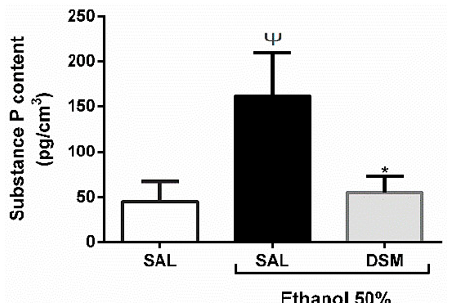
Figure 4. Effects of DSM supplementation on SP contents in gastric mucosa. The amount of SP in gastric mucosa was estimated by enzyme-linked immunosorbent assay (ELISA) and results were expressed as pg/cm 3 . Data shown are the mean ± SEM of at least 5 mice per group. The healthy group was treated with saline only. Ethanol administration significantly increased the gastric concentration of SP. This effect was reverted significantly when the animals were supplemented with DSM (10 8 CFU/g•bw/day for 3 days). Results were analyzed using one-way analysis of variance (ANOVA) followed by a Newman–Keuls post hoc test. Ψ p < 0.05 versus healthy group; * p < 0.05 versus injured